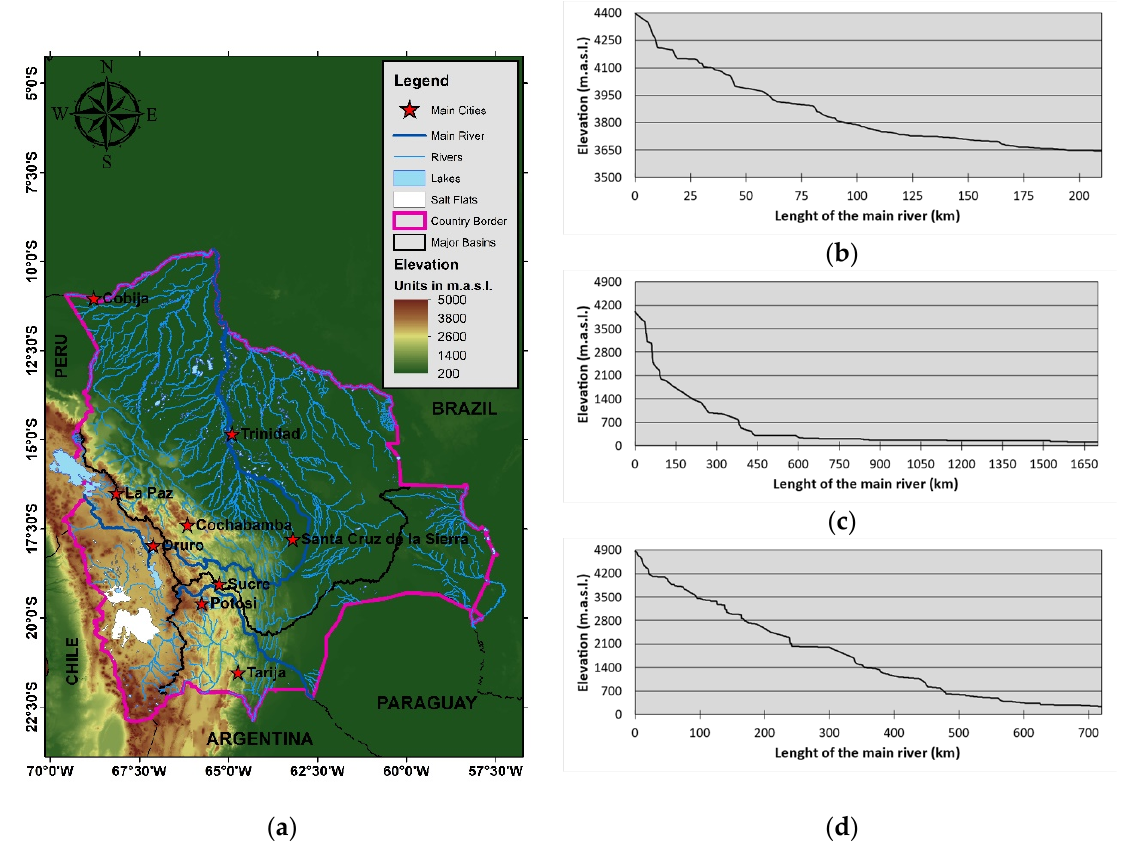
Figure 1. ( a ) Hydrological and orographic map of Bolivia and elevation profile for: ( b ) the Altiplano basin, ( c ) the Amazon basin and ( d ) the La Plata